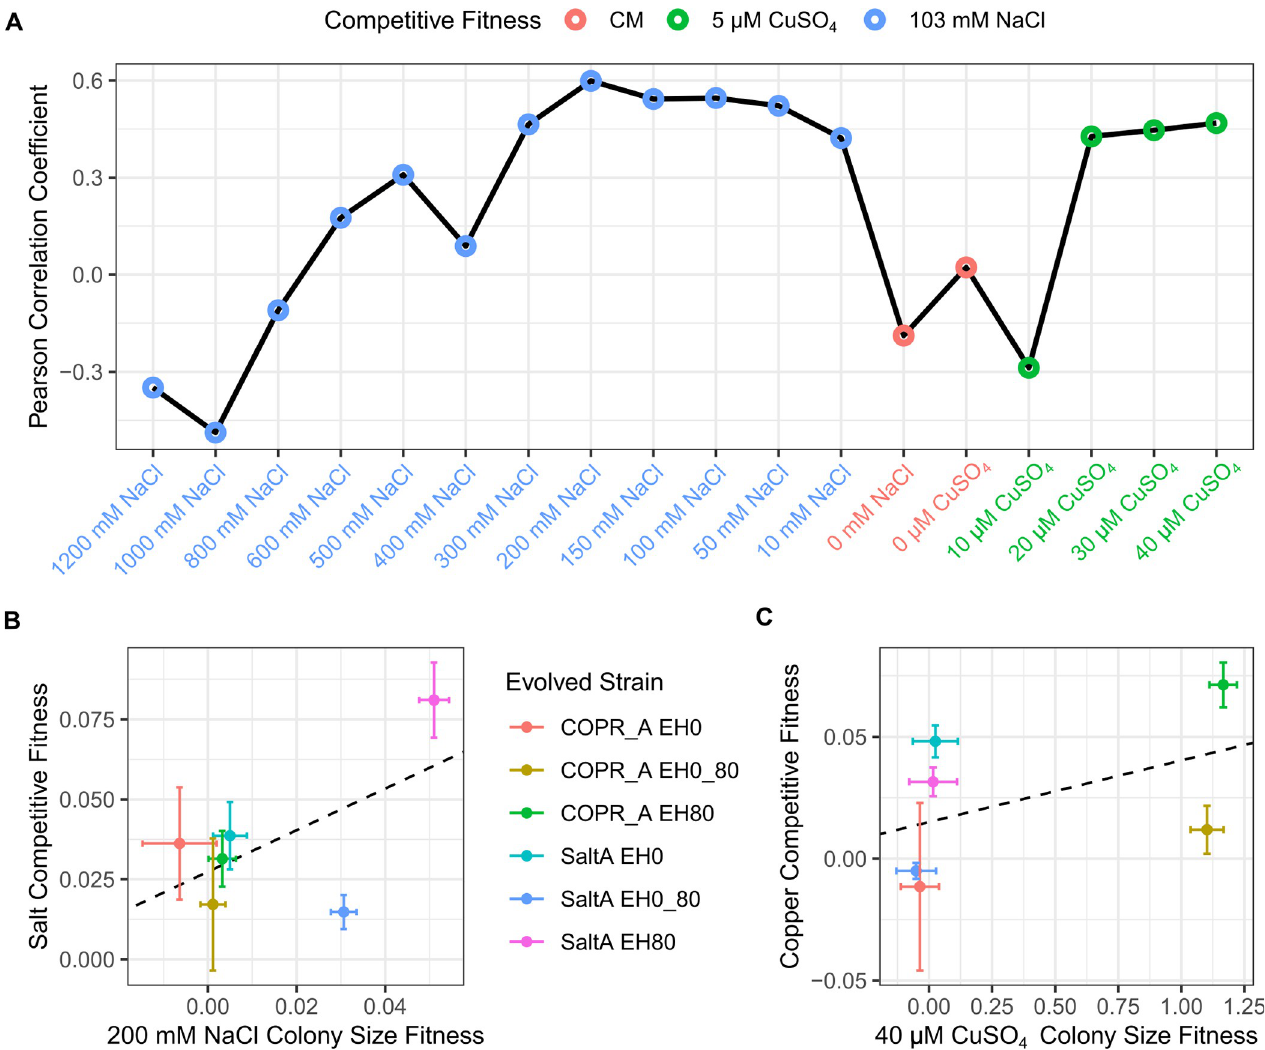
Fig 4. Comparison of fitness differences derived from competitive growth and colony size assays. Correlations between competitive fitness assays and the colony size assays with analogous stress conditions (A). Fitness differences of each evolved strain from competitive fitness and colony size assays under conditions with the highest correlation for sodium and copper stresses (B and C, respectively). Means are represented by points with 95% confidence intervals; the linear regression of the displayed means are shown by dashed